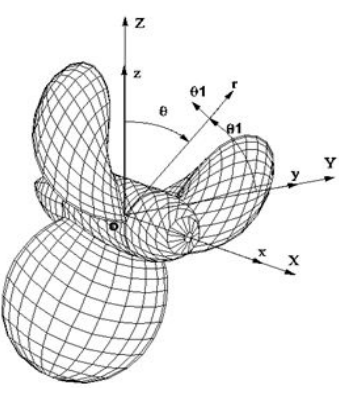
Figure 1. Propeller coordinate system.